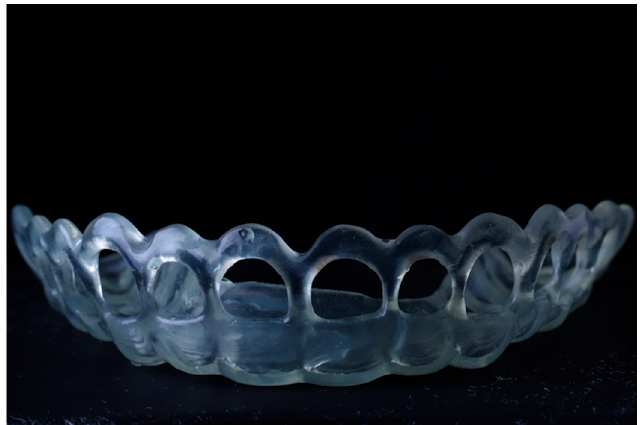
Figure 4. 3D-printed surgical guide.